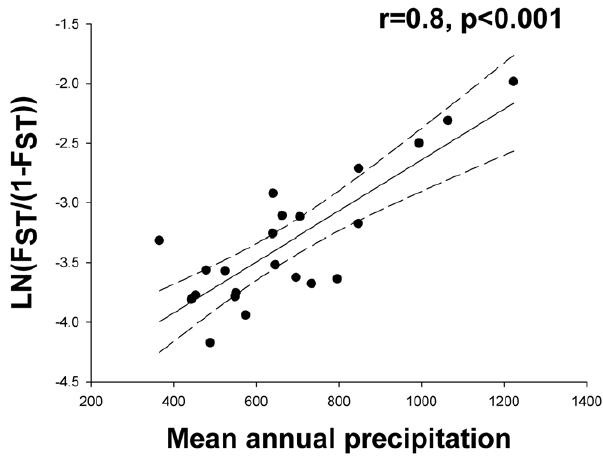
Figure 6. Relationship between the population specific F ST - values and mean annual precipitation at each population (see Table 5 and Results for additional statistics). doi:10.1371/journal.pone.0020440.g006 PLoS ONE |